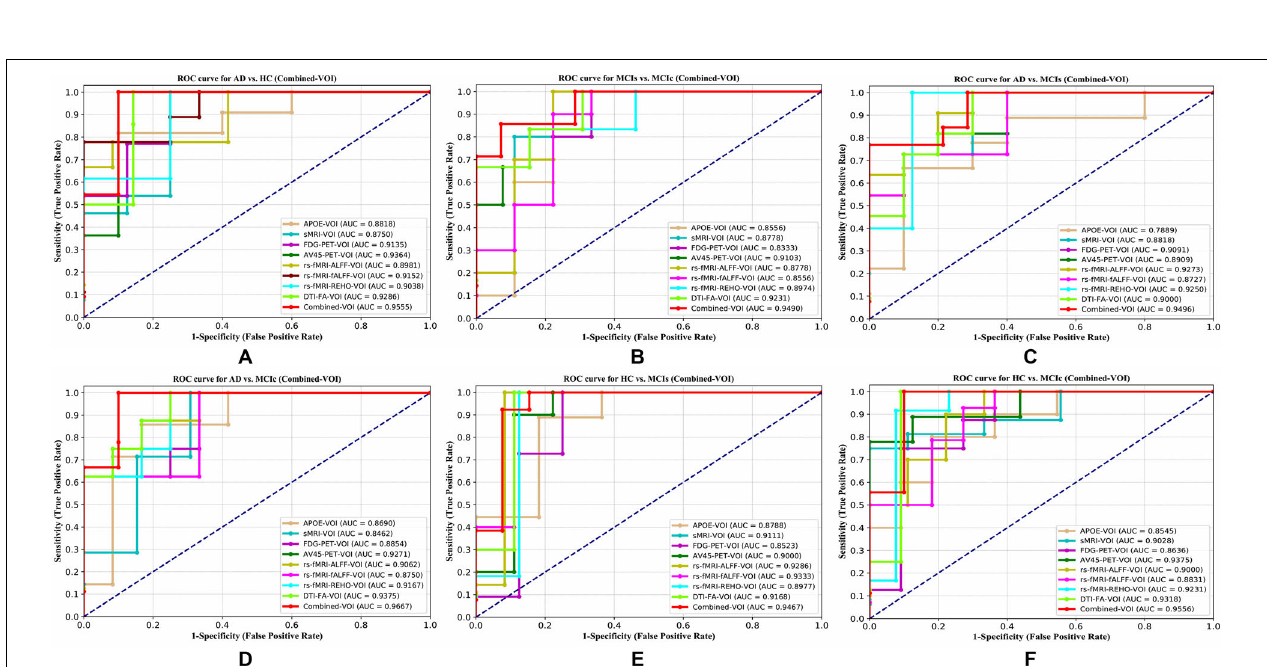
FIGURE 8 | Selected WM voxels for the (A) AD vs. HC, and (B) MCIs vs. MCIc classification using DTI image.